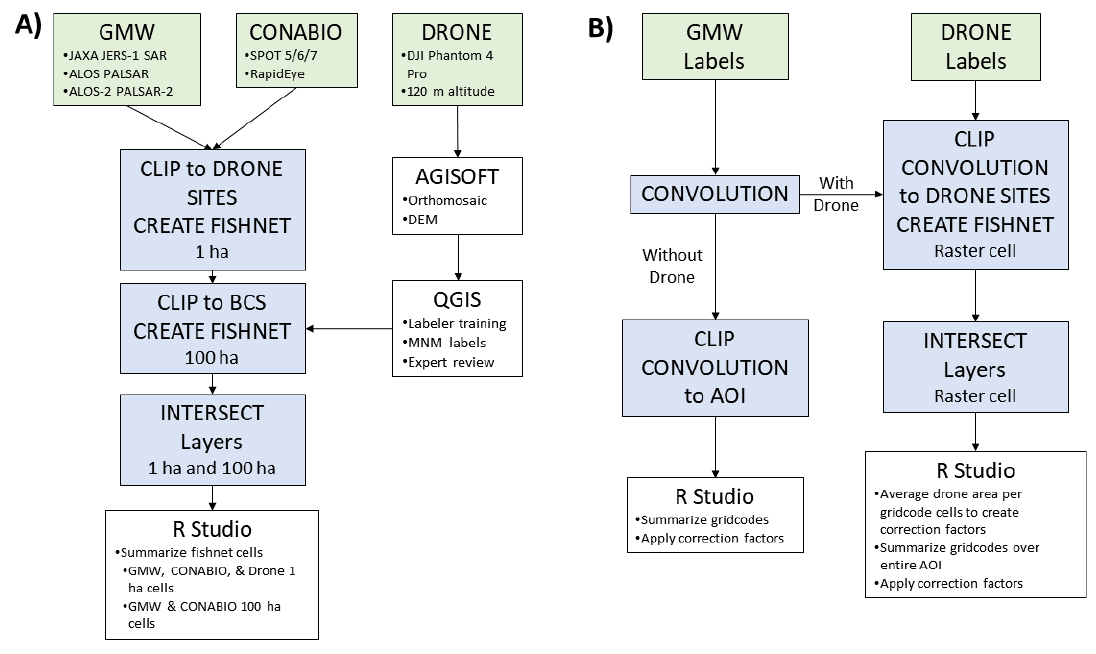
Figure 2. Workflow of methodology. Source imagery is detailed in green boxes, and analyses done in ArcGIS Pro are in blue boxes. MNM stands for mangrove / non-mangrove polygon classification and AOI stands for Area of Interest. R refers to the R Studio 1.2. ( A ) shows the workflow for dataset comparison of Global Mangrove Watch (GMW), National Commission for the Knowledge and Use of Biodiversity (CONABIO), and drone conducted in this study, while ( B ) shows the workflow for the convolution analysis to develop correction factors; ( B ) also indicates how the methodology of this paper can be implemented by other researchers.